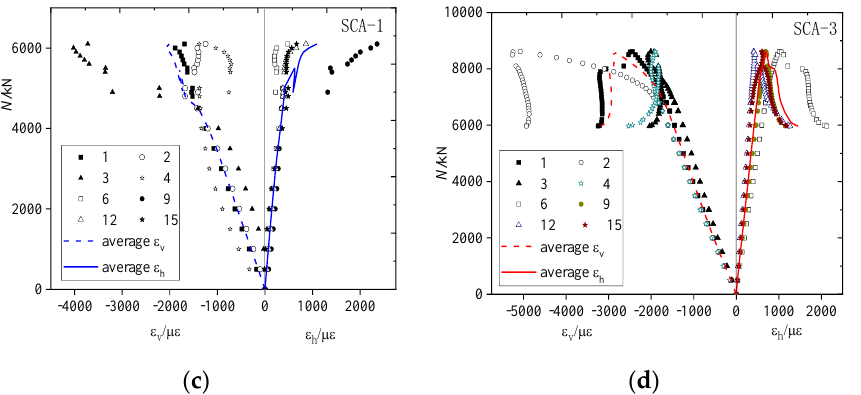
Figure 6. The stress of analysis of the rectangular CSFT short column. ( a ) Measuring point. ( b ) Load- Nominal Poisson’s ratio curve . ( c ) Load-strain curve of SCA-1. ( d ) Load-strain curve of SCA-2.